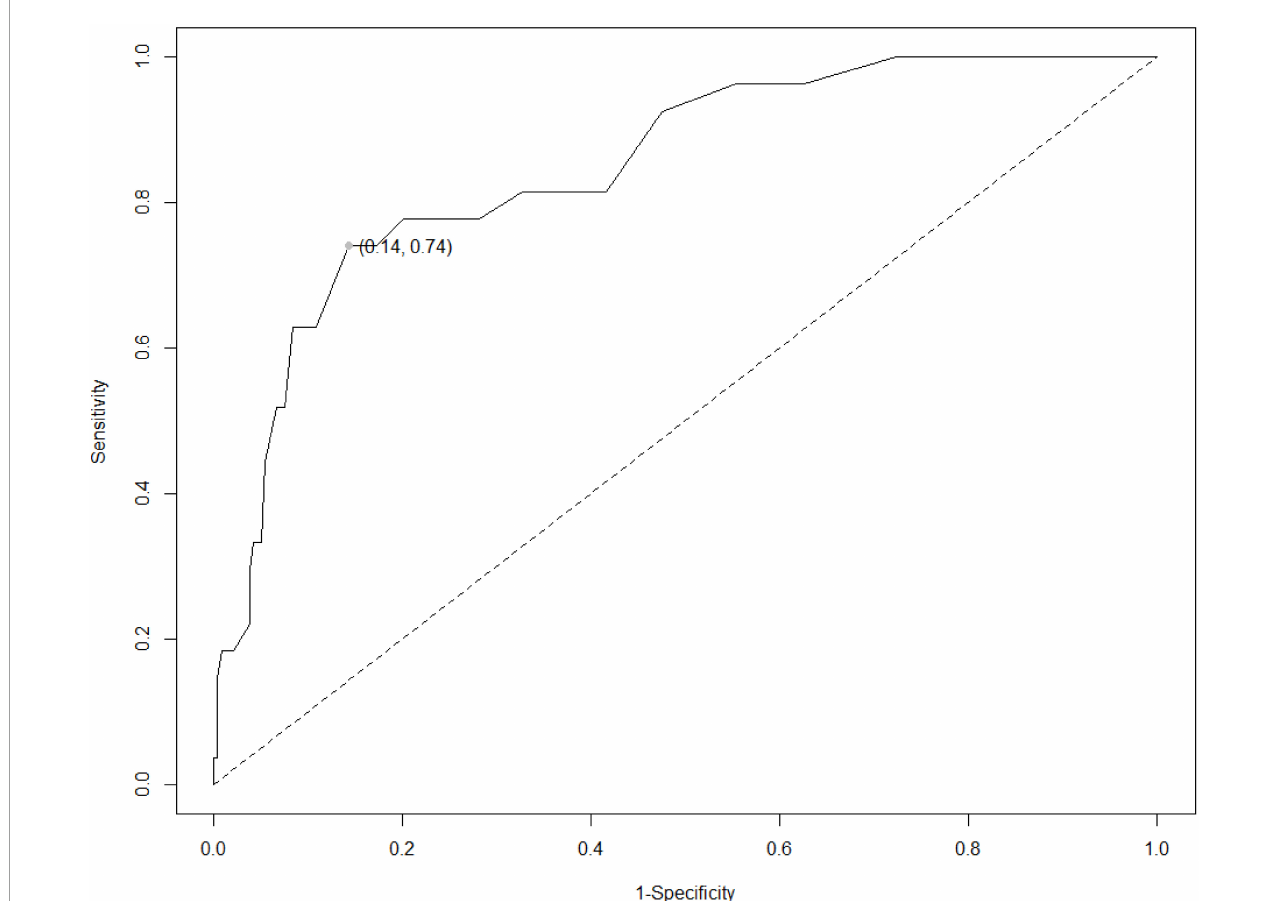
FIGURE1 ROC curve for the CBQ against an above-cutoff value on the ECAS-CI. ROC, receiver-operating characteristics; ECAS-CI, Edinburgh Cognitive and Behavioural ALS Screen; CBQ, Caregiver Behavioral Questionnaire. The gray dot index the cutoff value identified via Youden’s index [ ≤ 33; J = 0.6; AUC = 0.85; SE = 0.04; 95% CI (0.78;0.92)]. The graphical representation was implemented by means of the R package reportROC